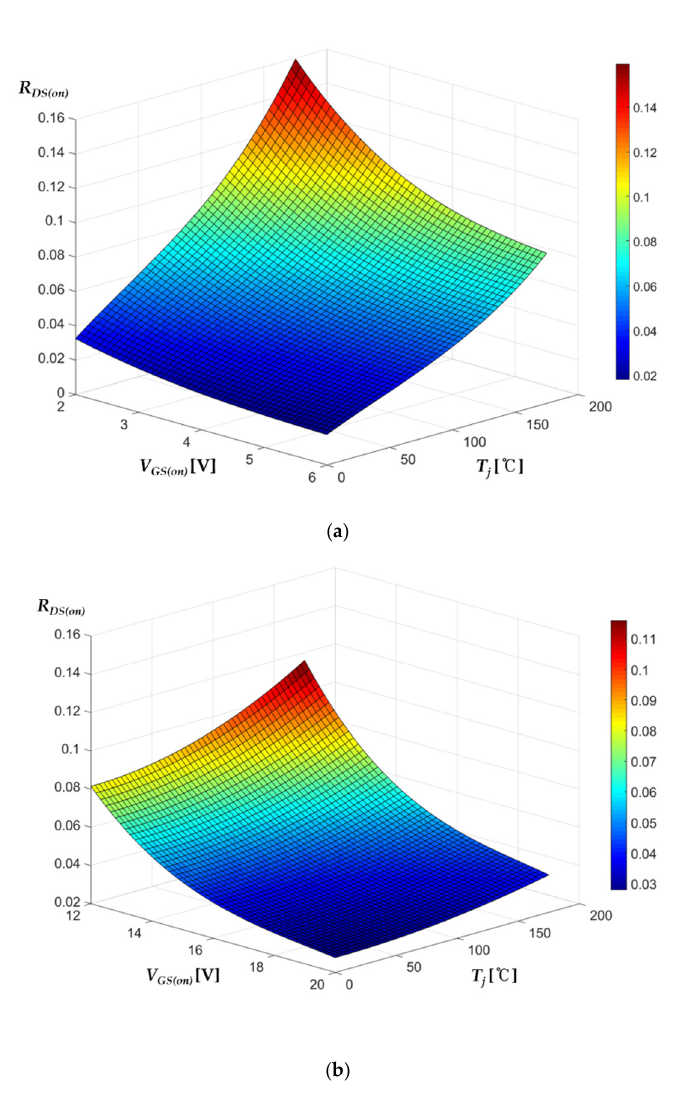
Figure 4. On-resistance according to the junction temperature and gate-source voltage: ( a ) gallium nitride (GaN) high-electron mobility transistor (HEMT); ( b ) silicon carbide (SiC) MOSFET.